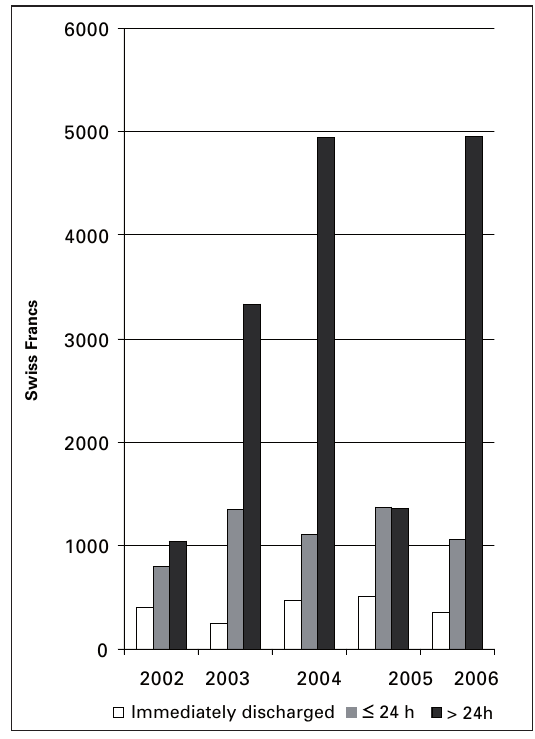
Median costs per patient between 2002 and